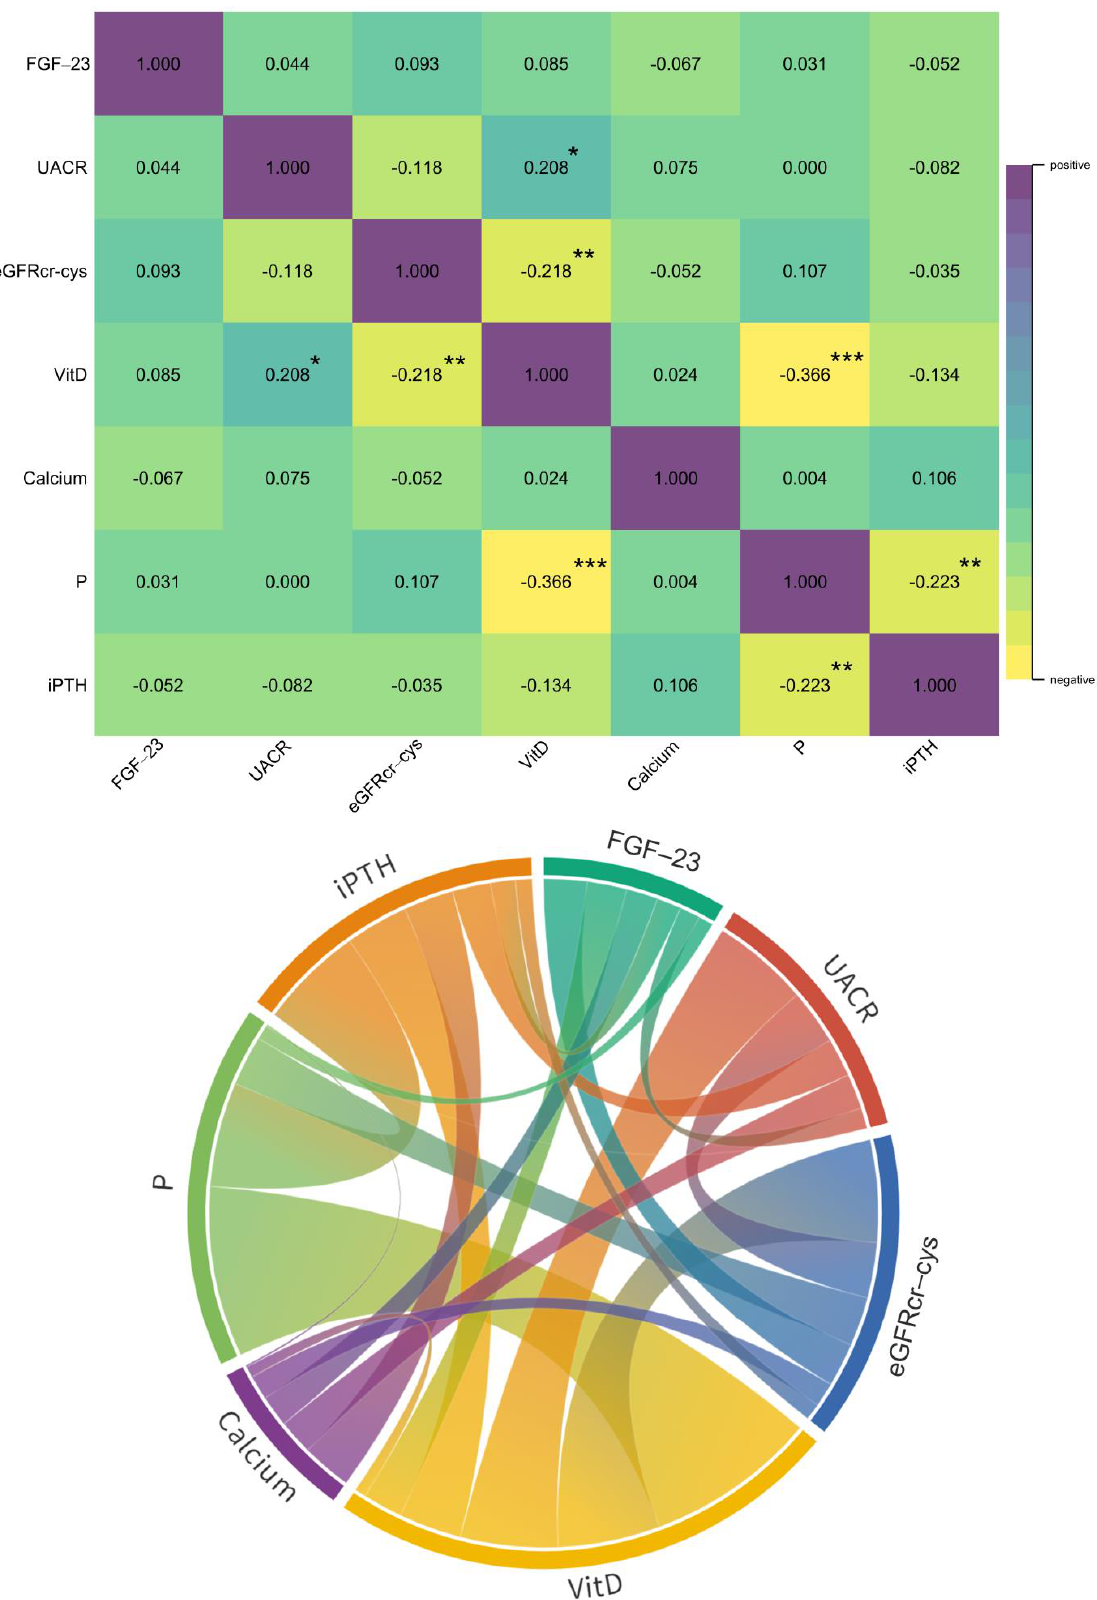
Figure 2. Correlations among FGF-23, UACR, eGFRcr-cys, vitamin D, calcium, inorganic phosphorus, and intact PTH. (* p -value < 0.05; ** p -value < 0.01; *** p -value < 0.001). The univariate regression shows 11 of the 44 variables (Table 1) were feasible prog- baseline FGF-23 (adjusted odds ratio (aOR): 2.87, 95% confidence interval (CI): 1.47, 5.62), eGFRcr-cys (aOR: 2.50, 95% CI: 1.54, 4.05), urine albumin-creatinine ratio (UACR) (aOR: 1.16, 95% CI: 1.03, 1.32), and central obesity (aOR: 5.09, 95% CI: 1.15, 22.60) had independ- ent prognostic significance for the likelihood of RKFD (Table 2). Furthermore, based on AUROC analysis, FGF-23 had significantly better discriminatory power for RKFD than UACR (AUROC: 0.803, 95% CI: 0.742, 0.865 versus AUROC: 0.591, 95% CI: 0.515, 0.667, respectively) and eGFRcr-cys (AUROC: 0.639, 95% CI: 0.565, 0.713) (Figure 3). Table 2. The prognostic significance of our variables for RKFD. Variables